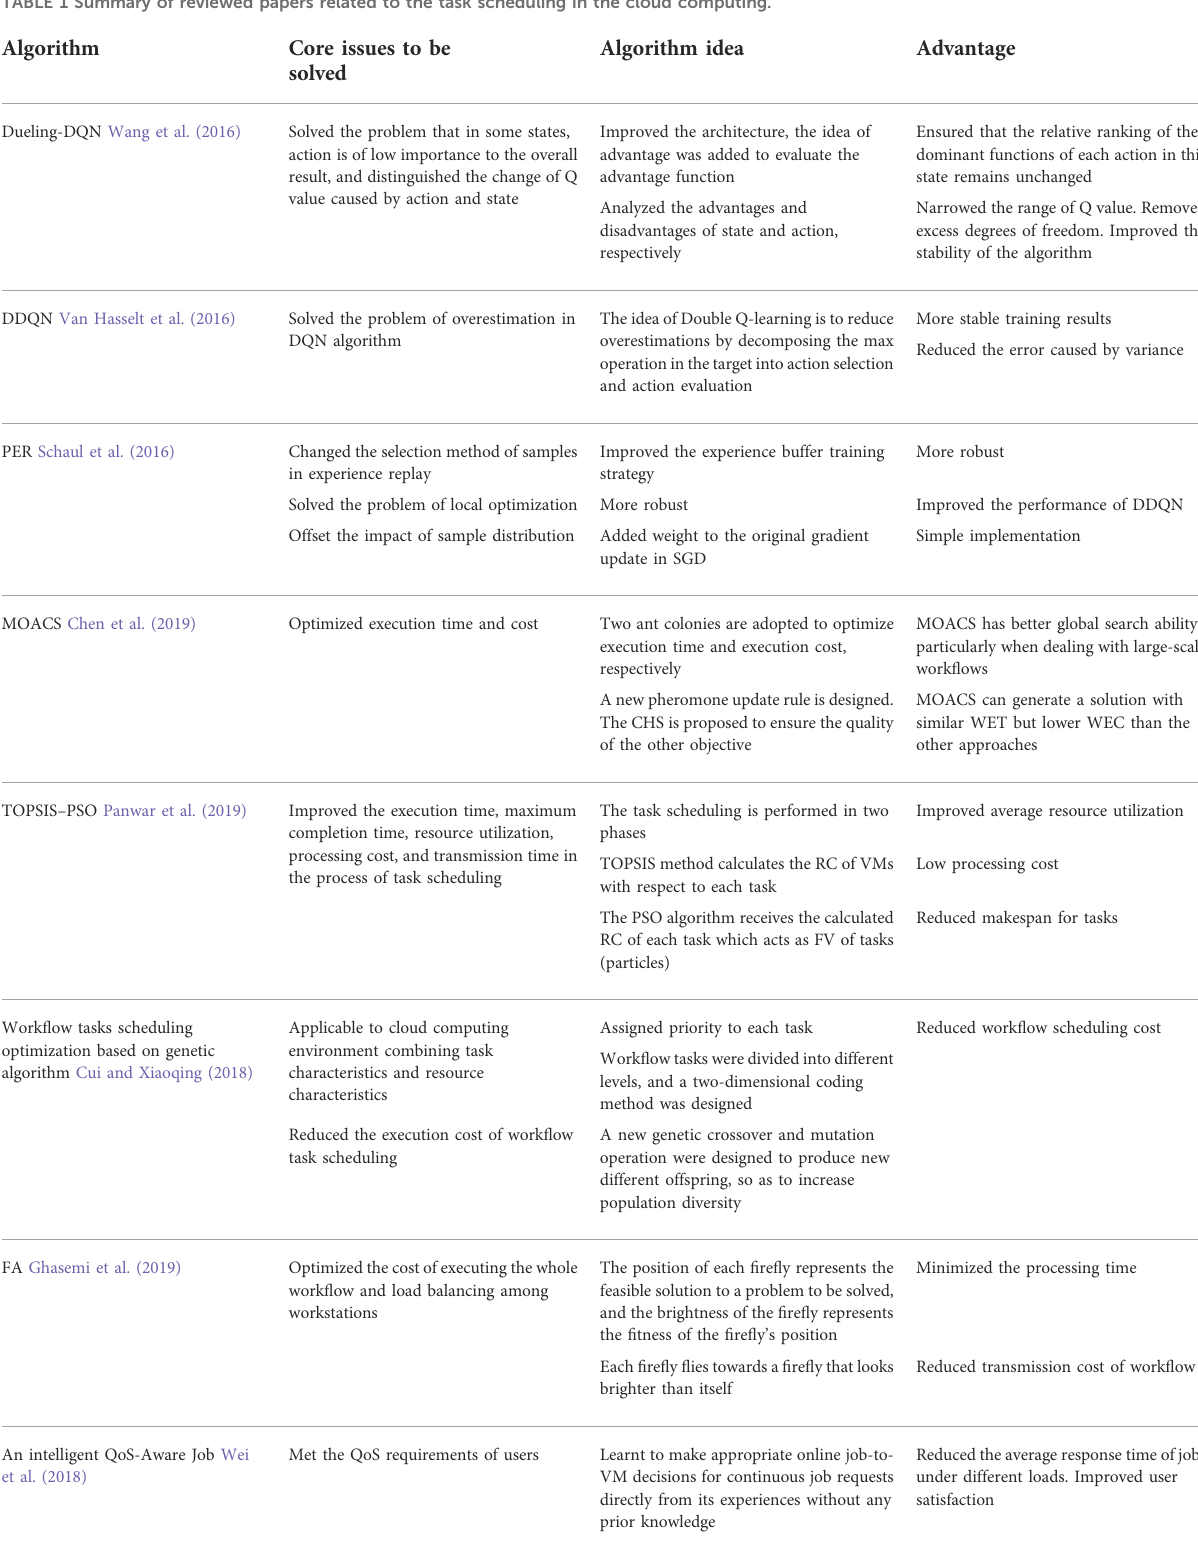
TABLE 1 Summary of reviewed papers related to the task scheduling in the cloud computing.